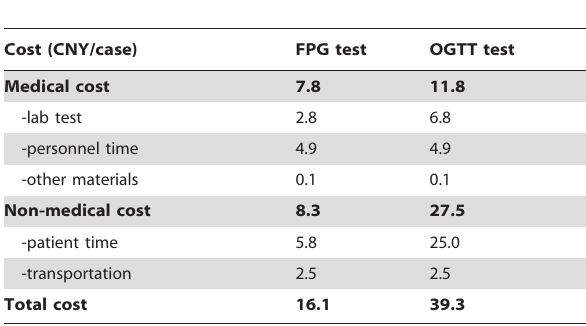
Table 1. Medical and non-medical costs for FPG test and OGTT